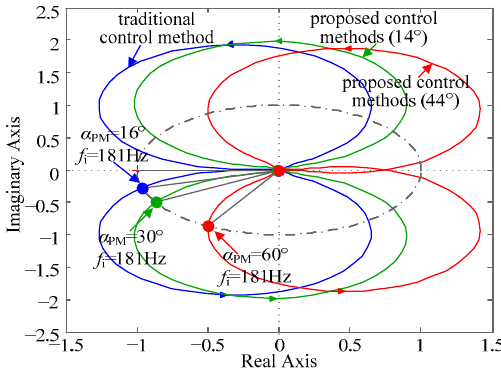
Figure 13. The Nyquist diagrams of the eigenfunction.